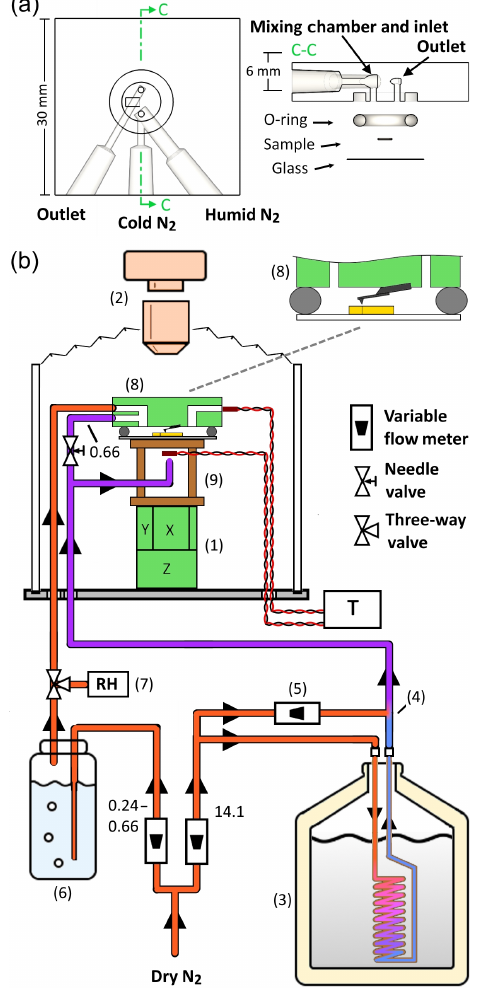
Figure 1. Experimental setup. (a) The three-port fluid cell. The port design separates the humid and cold gases before injection into the cell, in which the gases are then mixed to form a cold humid at- mosphere just before entry into the sample volume. (b) The over- all setup is built around an existing AFM (8) with top-down optics (2). Dry nitrogen is divided into cold and humid streams. The cold stream is nitrogen gas cooled in a liquid nitrogen-filled dewar (3), mixed at (4) with a dosage of room temperature nitrogen gas varied by (5). The total flow rate of the cold stream is unchanged; only the proportions of cold and warm flows are adjusted. The humid stream is generated by flowing nitrogen through a bubbler filled with wa- ter (6). The humid gas leaving the bubbler is directed by a three- way valve towards either a humidity sensor (7) or the sample cell. The cold and humid streams of nitrogen gas enter an acrylic bell jar which houses the AFM scanner (1) with a cellophane bellows bridging the optical objective (2) to the top rim of the jar. The hu- mid stream enters one port of the sample cell, while the cold stream is divided to cool the underside of the sample, by way of a copper standoff stage (9), and flow a smaller proportion into the other port of the sample cell. The temperature of the underside of the sample stage and of the gas exiting the cell are measured with thermistors. The decimal values next to flow line segments are flow rates for those segments in liters per